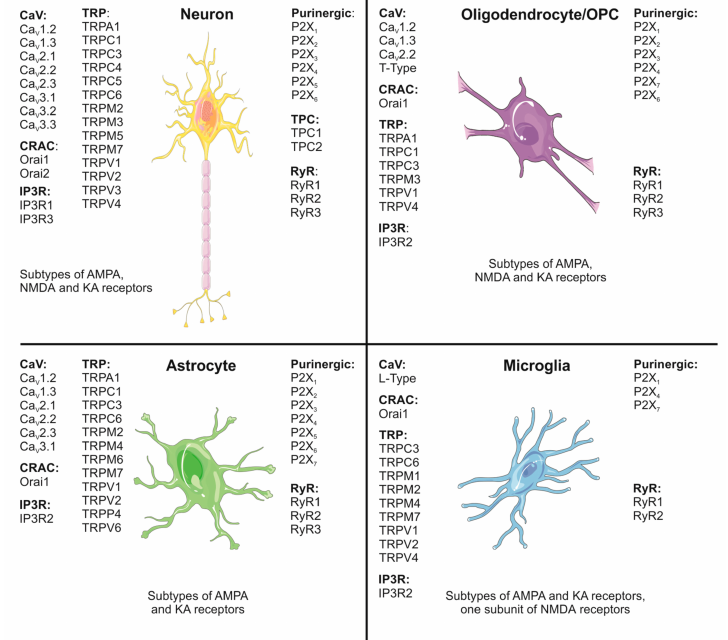
Figure 1. Expression profile of calcium channels in mammalian central nervous system (CNS) cell types. The image shows neurons (yellow), oligodendrocytes (purple), astrocytes (green) and microglia (blue). For a detailed description please refer to the